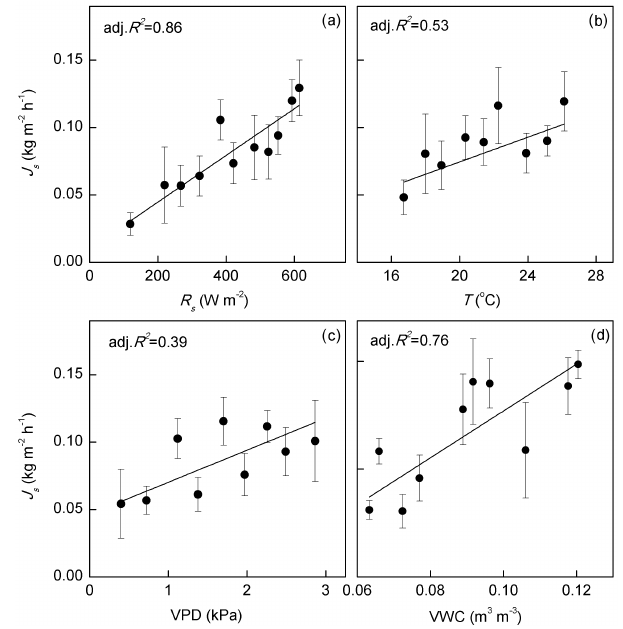
Figure 3. Relationships between sap flow per leaf area ( J s ) and environmental factors (shortwave radiation, R s ; air temperature, T ; water vapor pressure deficit, VPD; and soil water content at 30cm depth, VWC) in non-rainy days between 08:00 and 20:00 during the mid-growing season of 1 June to 31 August for 2013 and 2014. Data points are binned values from pooled data over 2 years at increments of 40Wm − 2 , 1.2 ◦ C, 0.3kPa, and 0.005m 3 m − 3 for R s , T , VPD, and VWC,